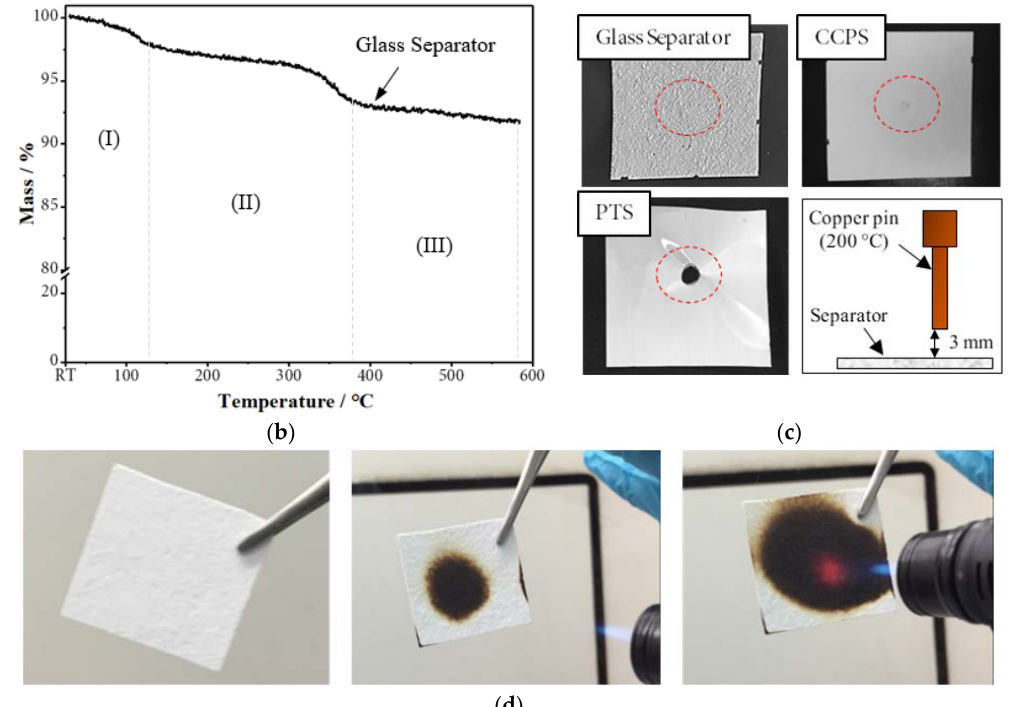
Figure 5. Thermal stability of a glass fiber nonwoven/glass platelet composite separator, ( a ) temperature-dependent shrinkage (hot-oven test) compared to polymer-based separators; ( b ) thermogravimetric analysis; ( c ) behavior at exposures to 200 °C by heat radiation (hot-punch test); ( d ) demonstration of the flame retardation of the glass composite separator.